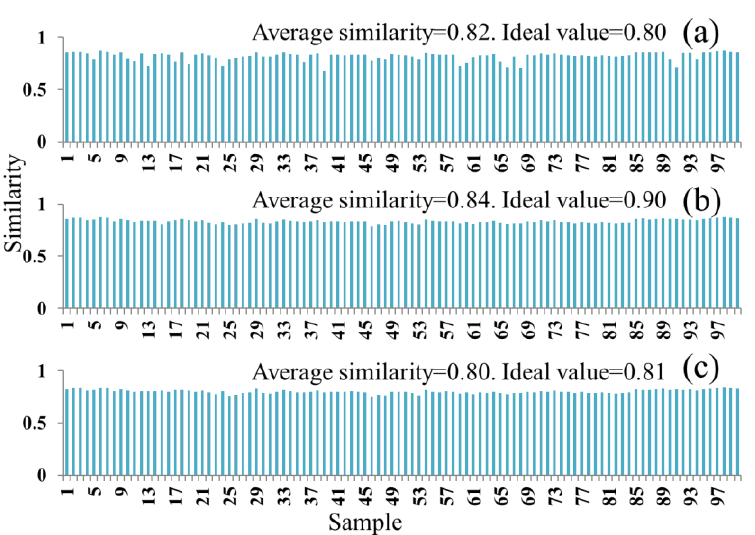
Figure 7. The registration similarity of the scaling images. ( a ) Scaling factor = 0.8; ( b ) scaling factor = 0.9; and ( c ) scaling factor = 1.1.